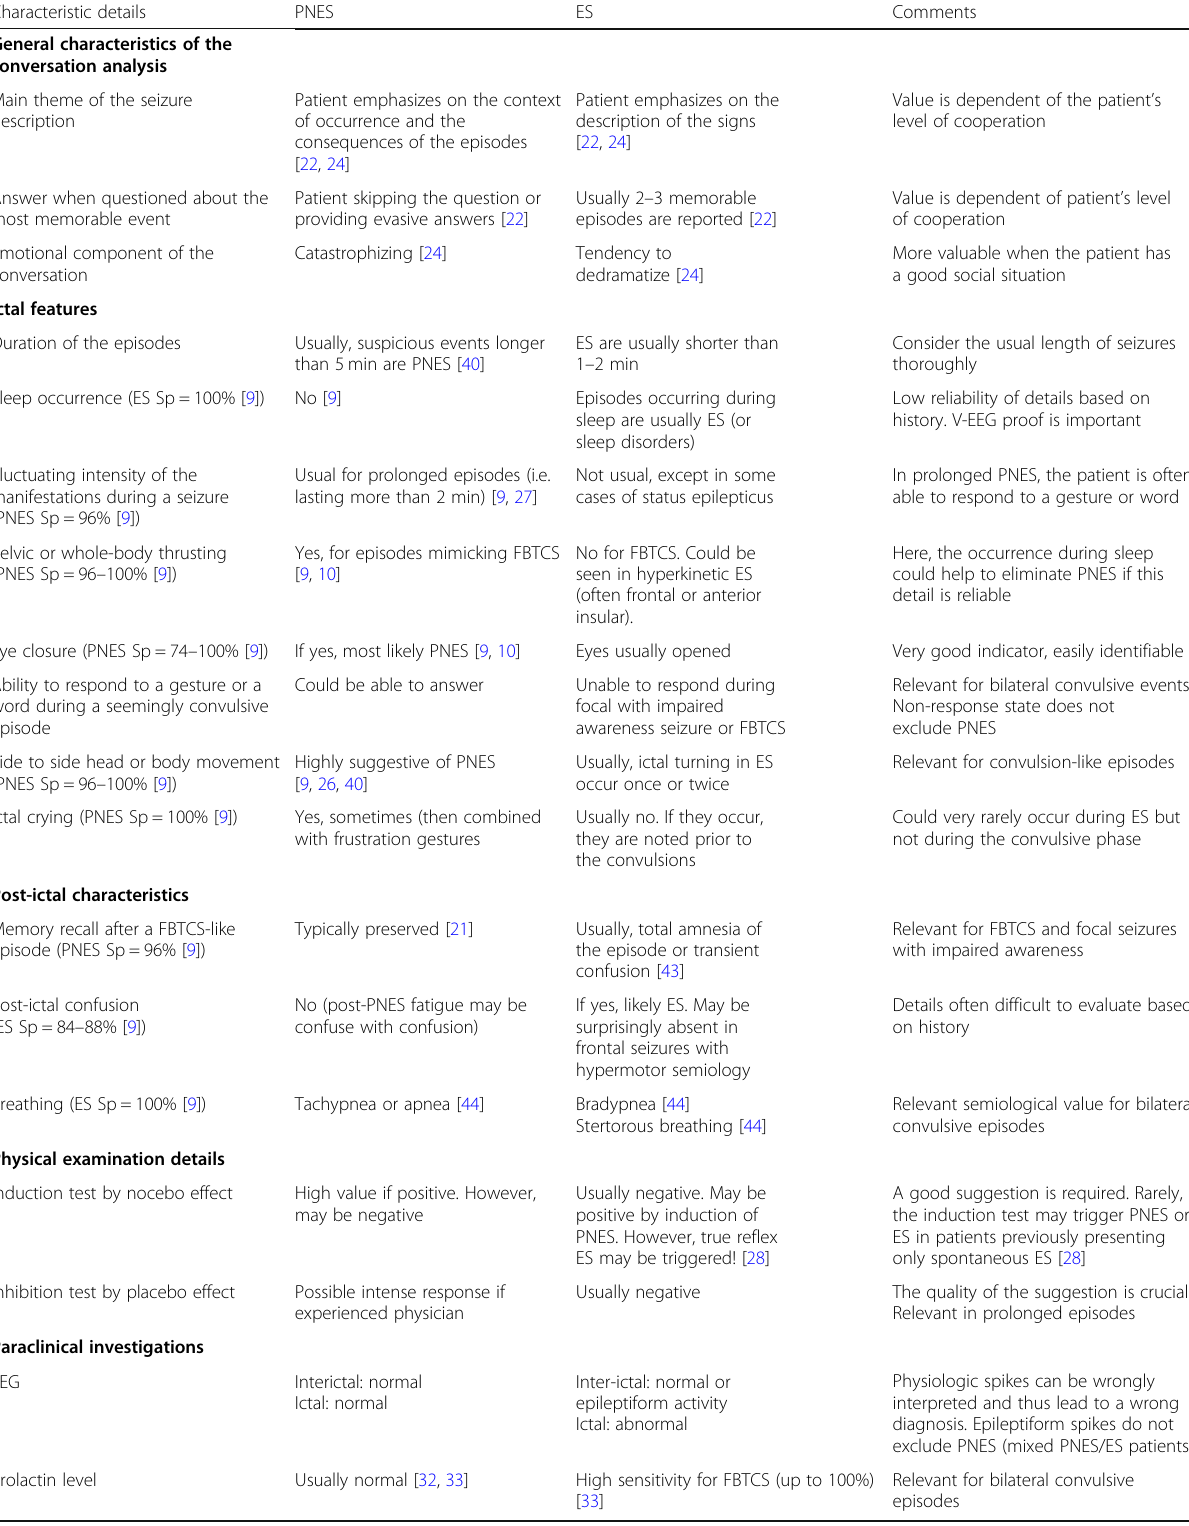
Table 1 Main semiological details distinguishing PNES from